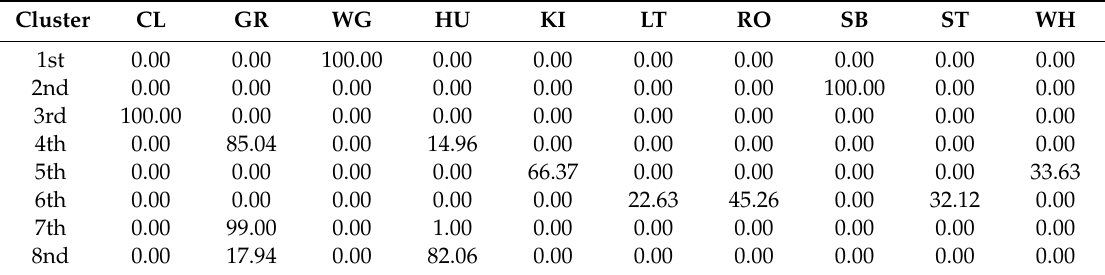
Table 2. Vocal type assignment detailed accuracy by class. TP rate: Rate of true positives; FP rate: Rate of false positives; precision: Proportion of instances that are truly of a class divided by the total instances classified as that class; F-measure: Combined measure for precision and recall; ROC area: Receiver operating characteristics measurement area; PRC area: Precision recall area.